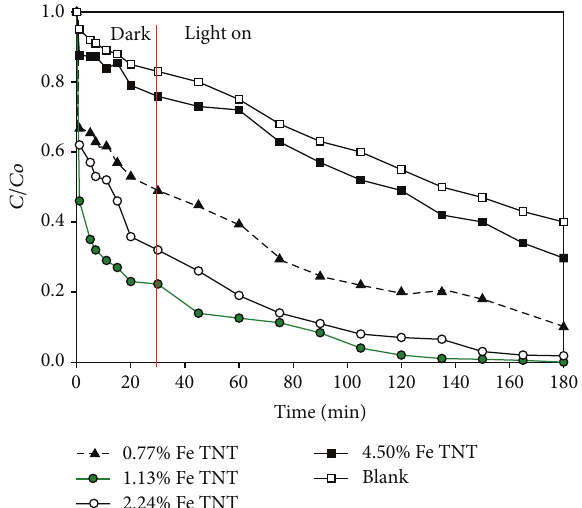
Figure 10: Pseudo-first-order kinetics plot for decolorization of 10ppm MB, RBK5, and DB22 with 0.13 gL −1 catalyst under 254 nm light